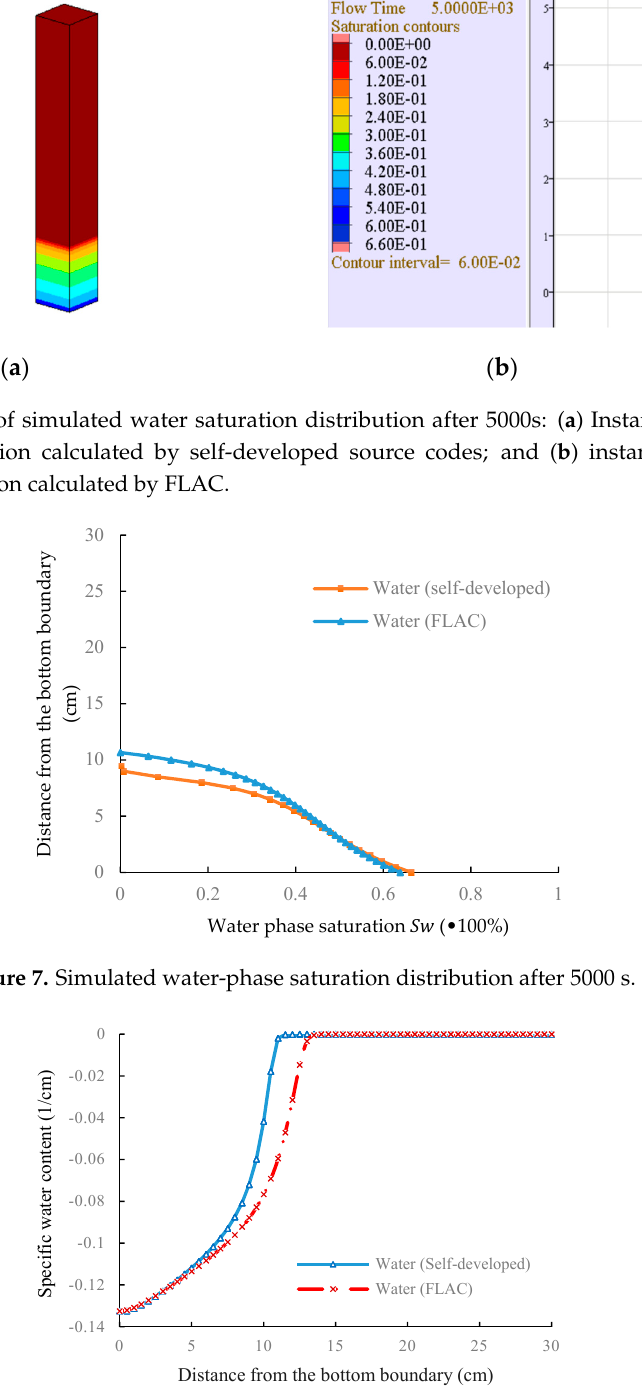
Figure 6. Contrast of simulated water saturation distribution after 5000s: ( a ) Instantaneous water saturation distribution calculated by self-developed source codes; and ( b ) instantaneous water saturation distribution calculated by FLAC.